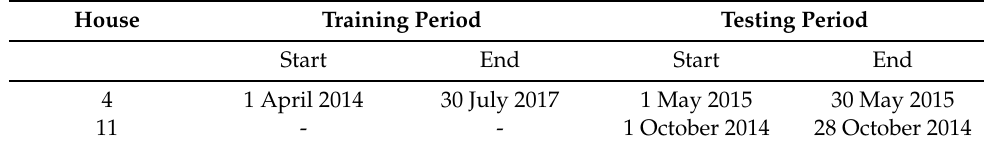
Table 3. The details of the data used during phase